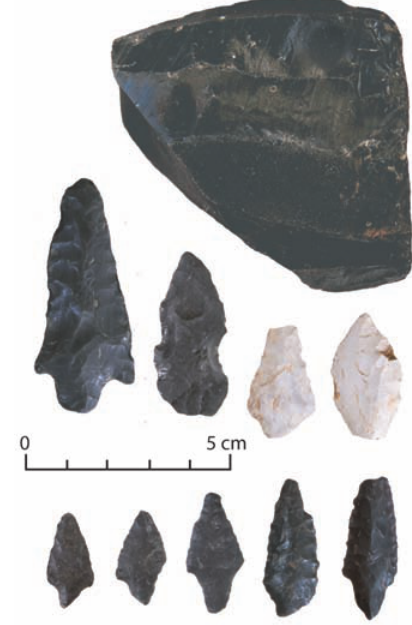
Figure 6 View looking north across the village of Potamos, with the Hellenistic fortified town Figure 4 An obsidian blade core and projectiles (“Kastro”) across the water in the points in both obsidian and white chert.